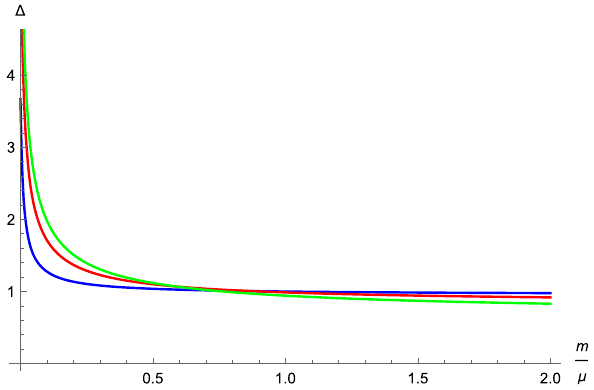
Fig. 6 Variation of the dimensionless phase space area (cid:11) , with respect to the dimensionless mass parameter m /μ of the system, where we have taken |(cid:5) k | /μ = 1 and, for g = 0 . 5 (blue curve), g = 1 (red curve) and g = 1 . 5 (green curve). See main text for discussion